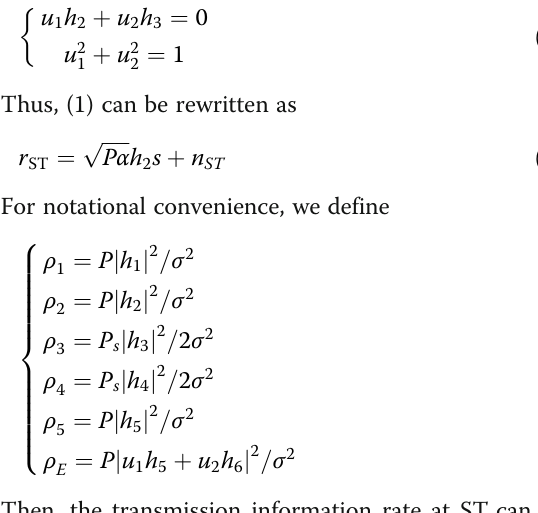
The achievable secrecy rate is defined as the difference between the achievable rate of main channel and the achievable rate of eavesdropper channel. Obviously, the achievable secrecy rate is the lower bound of the secrecy capacity.